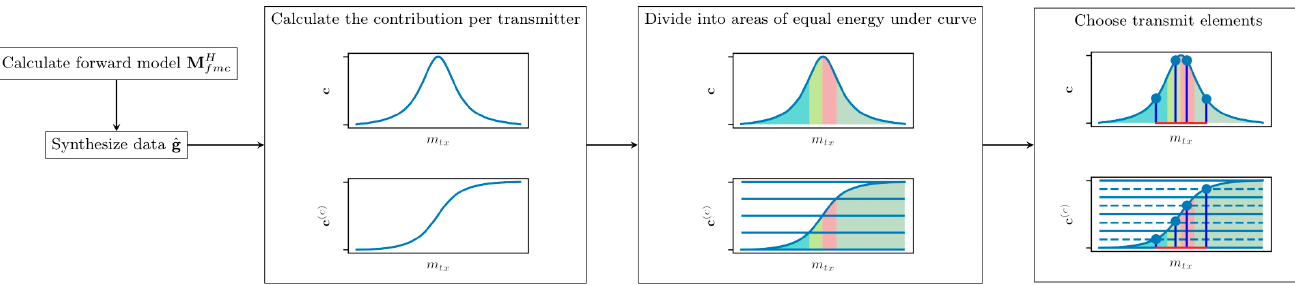
Figure 2. Summary and illustration of the pattern selection procedure.